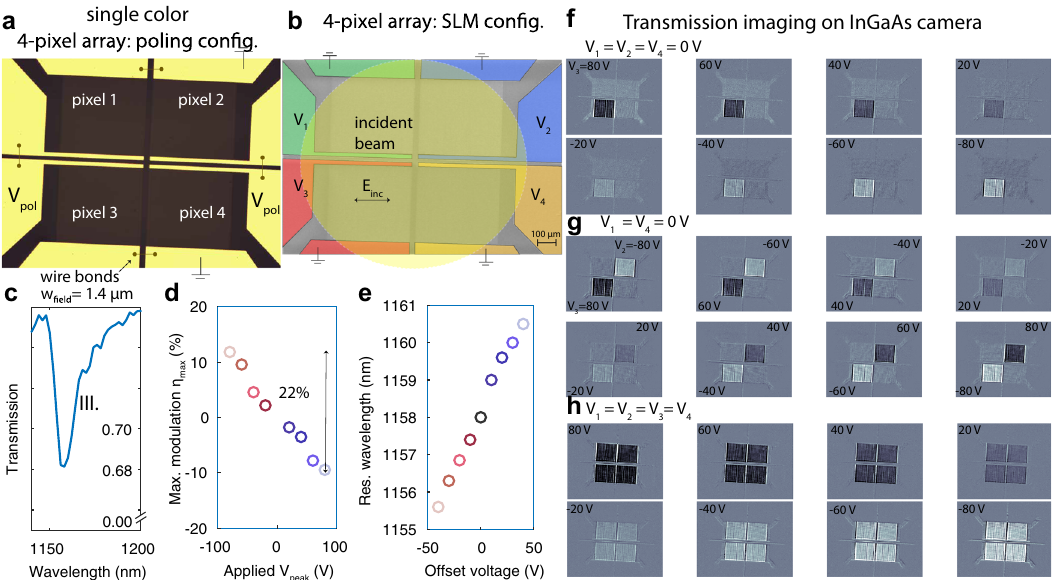
Fig. 5 Imaging properties of the monolithic 4-pixel spatial light modulator. a Optical microscope image describes the geometrical and electrical con fi guration of the 4-pixel array (yellow regions are the bonding pads that connect the metallic grating). All four pixels are identical and connected in parallel during the poling procedure and are thereby all activated in one single run. b False-color scanning electron micrograph shows the color-coded control voltages V 1 − V 4 and the incident beam that probes the entire SLM in transmission. c For this demonstration, we choose to operate on mode III. of a modulator with w fi eld = 1.4 μ m, which exhibits a maximal modulation strength of 22% at 100 kHz shown in d , and a tuning of the resonant wavelength by 5 nm, shown in e . f – h Pixels are individually addressed by the set of voltages V 1 , V 2 , V 3 , V 4 and the intensity distribution of an incident beam after transmission through the SLM is recorded with a InGaAs camera at low speed (25 Hz, limited by the camera). The transmission experiments con fi rm a successful concomitant poling of all four pixels (thereby of an area 780 × 780 μ m 2 ), comparable performance of all pixels, as well as independent control over their transmission properties. All pictures are generated by subtracting the transmitted intensity pattern when the modulator is not biased i.e.,